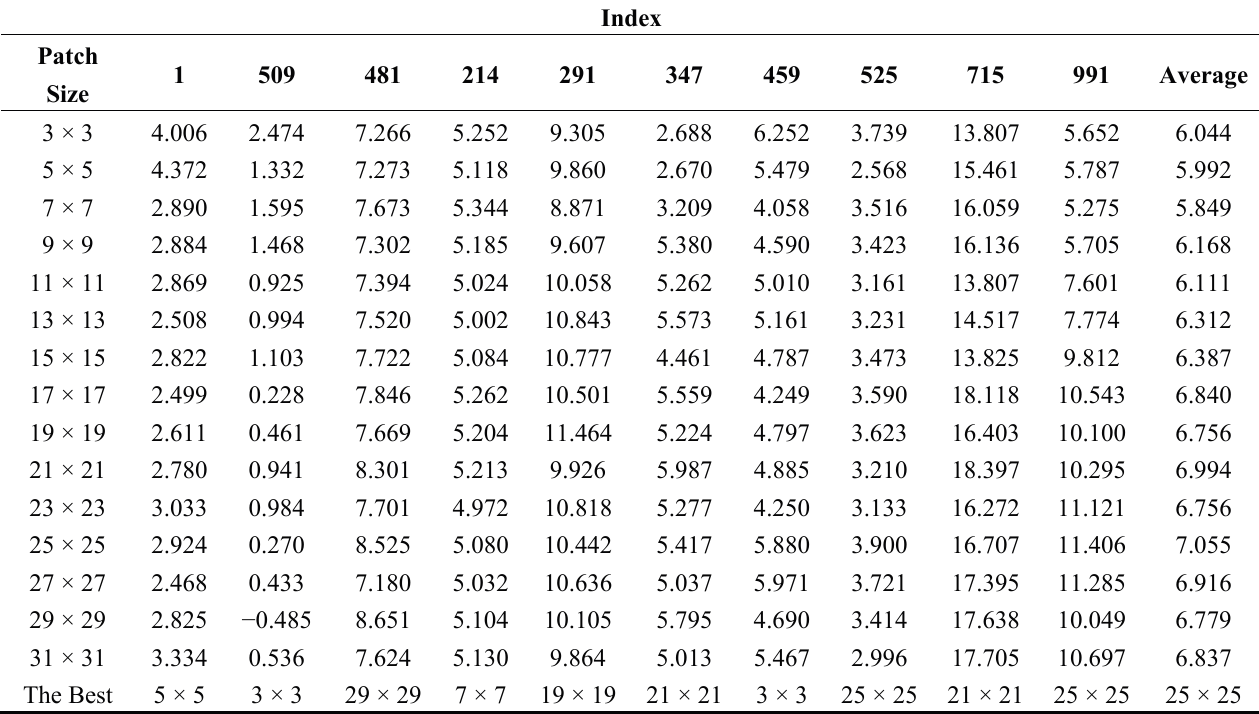
Table 1. Mean PSNR improvement vs. patch size.